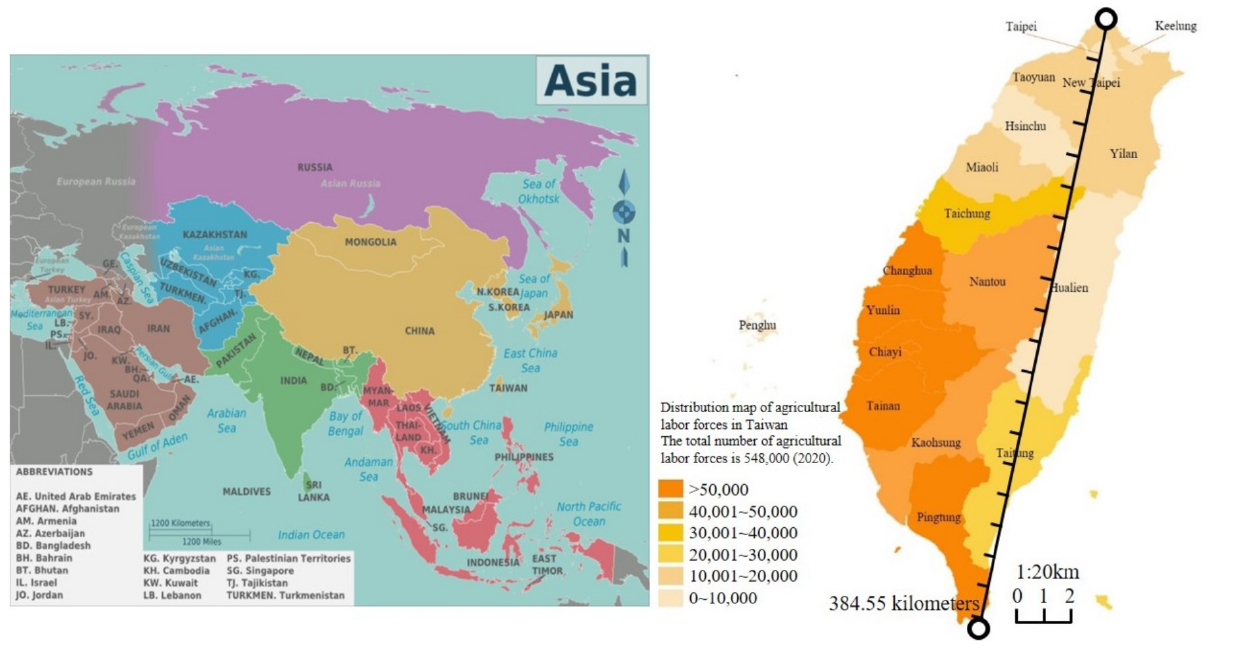
Figure 1. Taiwan’s agricultural work force by province. (Wikipedia, https://zh.wikipedia.org/wiki/ File:Map_of_Asia_draft2.png, accessed on 3 March 2022; amCharts, https://pixelmap.amcharts. com/, accessed on 19 February